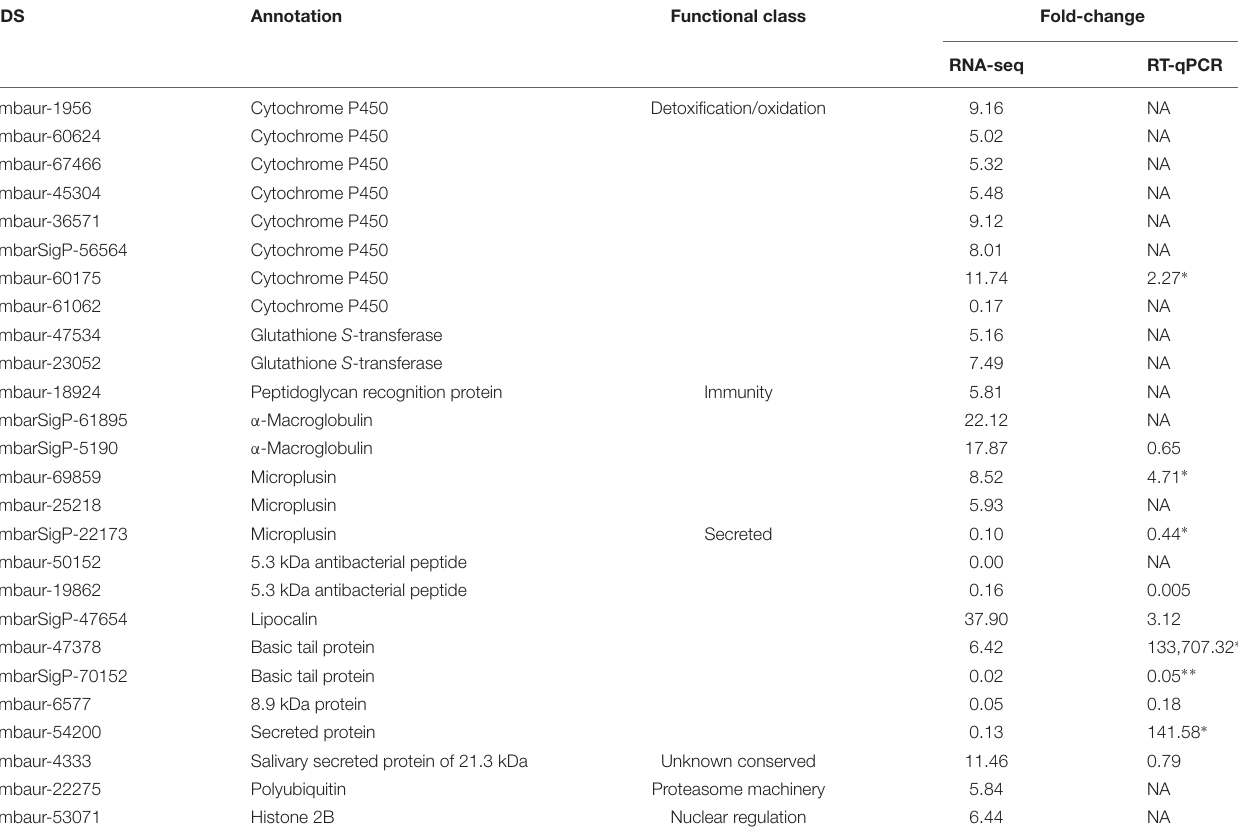
TABLE 1 | Selected CDSs of A. aureolatum salivary glands differentially expressed by infection with R. rickettsii .